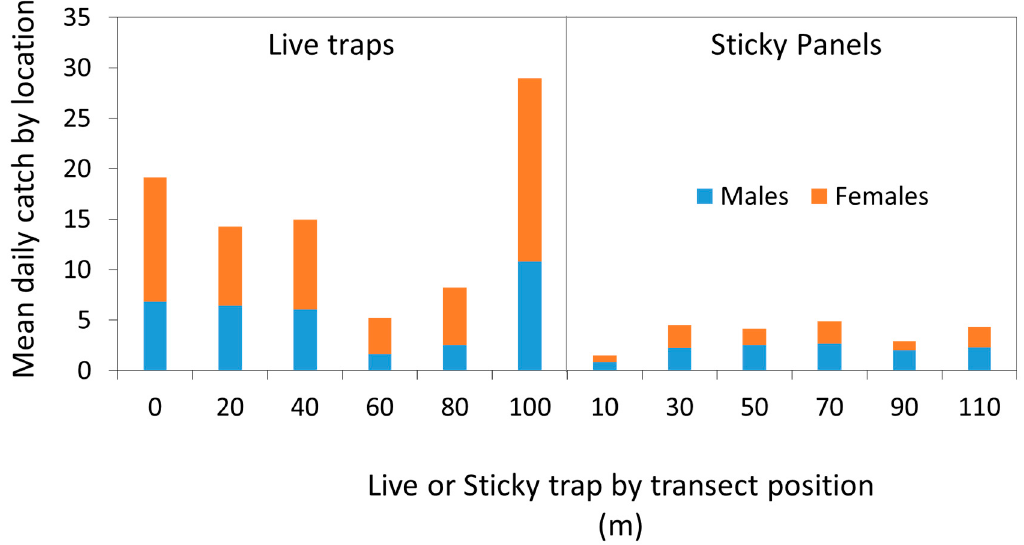
Figure 4. Effect of transect positions on mean daily catch of Halyomorpha halys by sex and trap type at the forest–vineyard margin in San Michele all’Adige (TN), Italy (n = 6 replicates, operated for 14 days (runs combined)).